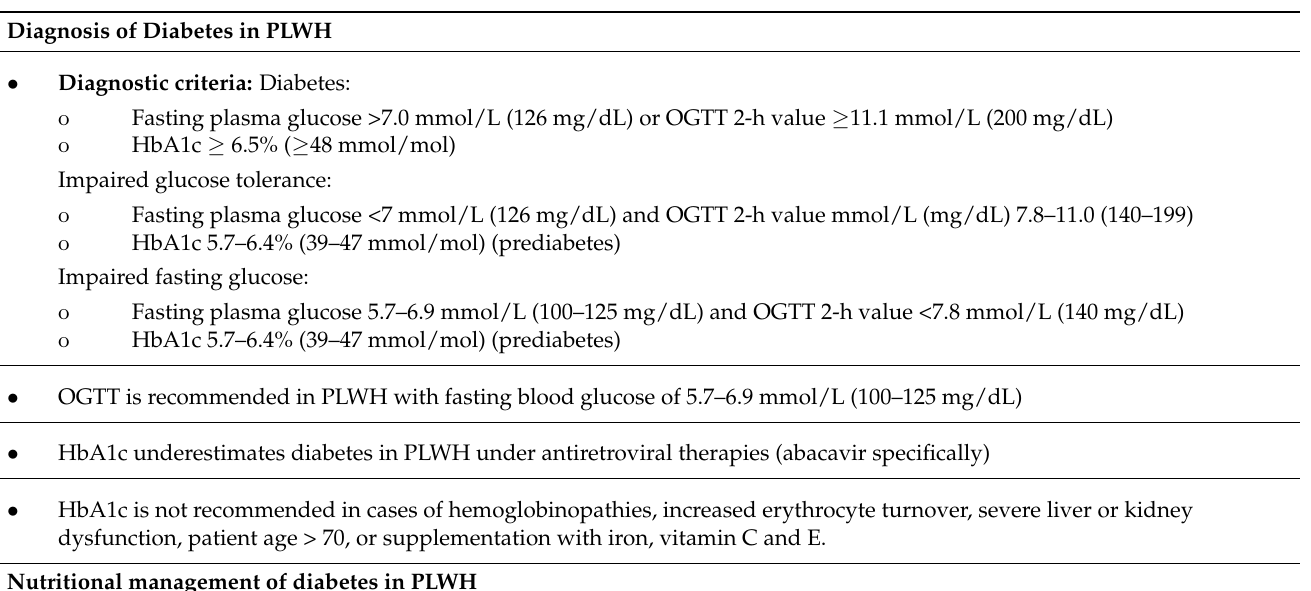
Table 2. Overview of diagnosis and nutritional management of diabetes in PLWH